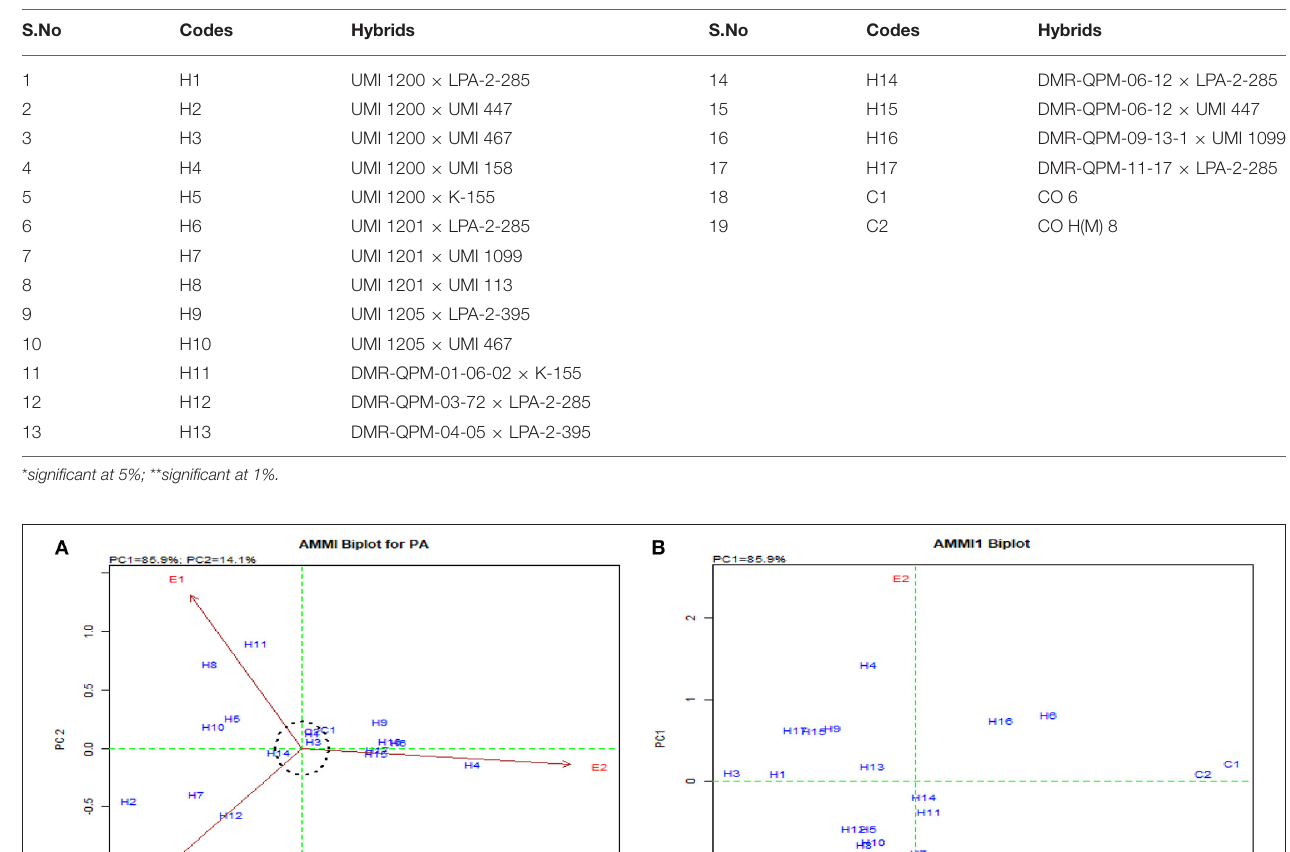
TABLE 5 | The codes for the selected hybrids subjected to AMMI and GGE.